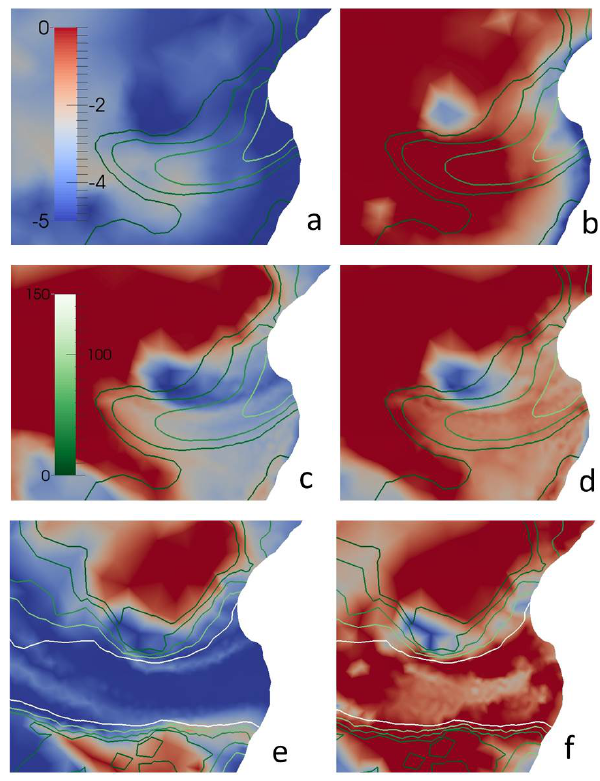
Fig. 8. Basal temperatures (in centigrade relative to the pressure melting point) in the Basin 3 outlet glacier region from steady state simulations described in Section 3.2.1: (a) diffusion only, geothermal heat flux halved (SSLG); (b) diffusion only (SS); (c) full thermodynamics with 1995 dynamical regime except that frictional heating is omitted (SS95NF); (d) full thermodynamics with 1995 dynamical regime (SS95); (e) full thermodynamics with 2011 dynamical regime except that frictional heating is omitted (SS11); (f) full thermodynamics with 2011 dynamical regime (SS11NF). 1995 (a to d) and 2011 (e and f) velocity contours (in ma − 1 ) are overlain to indicate regions of fast flow.